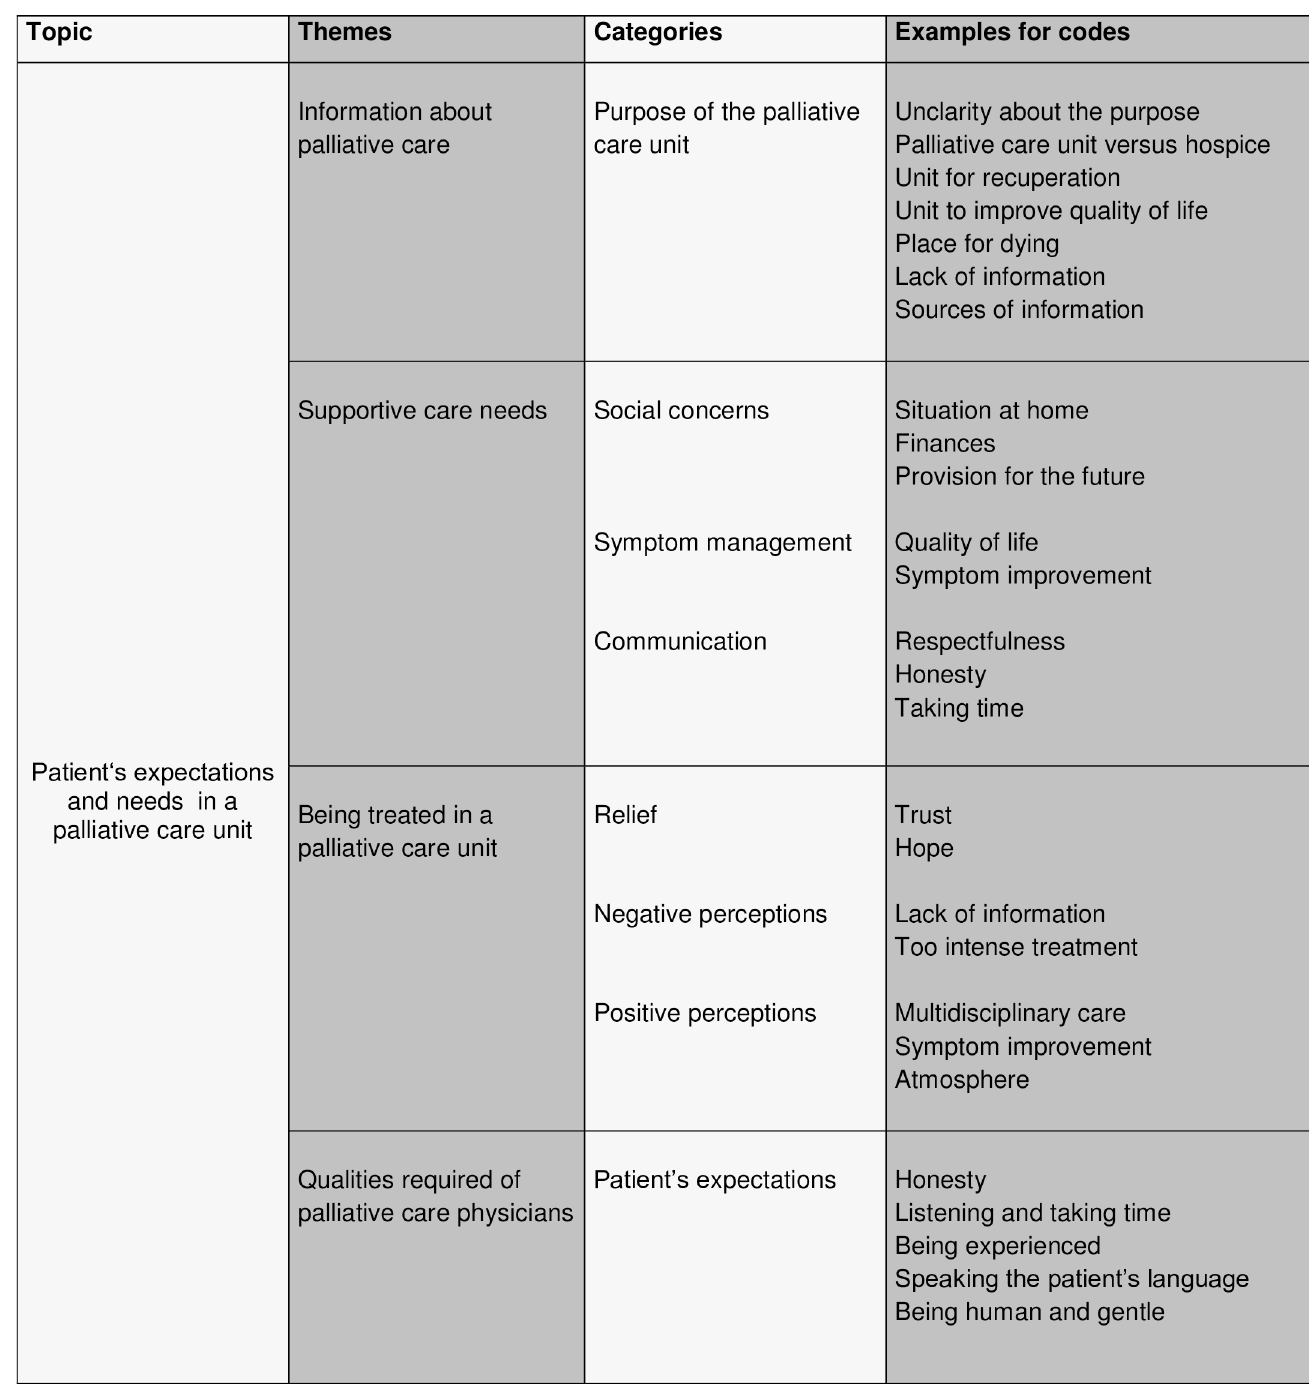
Fig 1. Themes, categories and codes generated from patient interviews. Fig 1 depicts the themes, categories and examples for codes identified from patient interviews. Codes relate to the patients ‘ knowledge of palliative care, their expectations and perceived needs when being admitted to a palliative care unit, and their concept of a good palliative care physician.